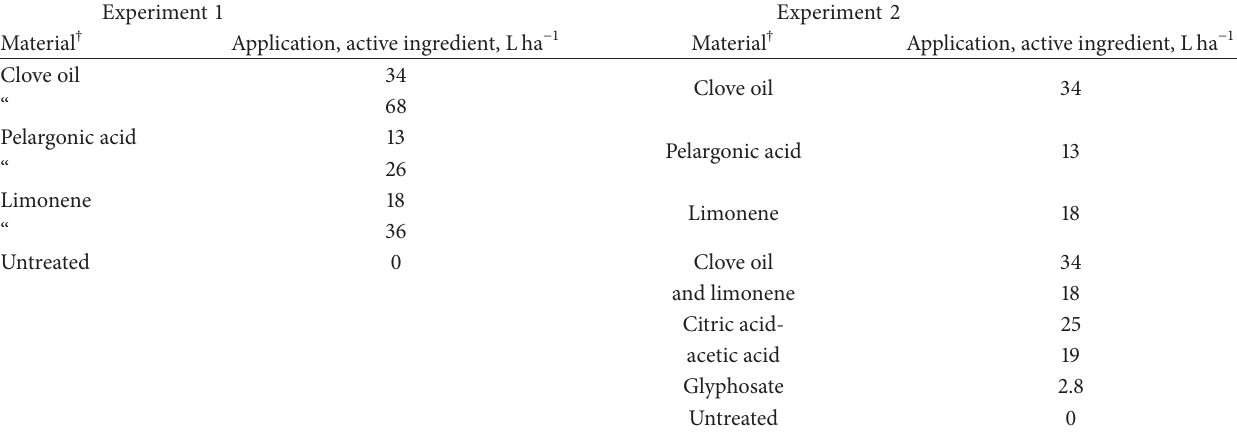
Table 4: Treatments employed in two experiments in roadside research with alternative herbicides (Roadside